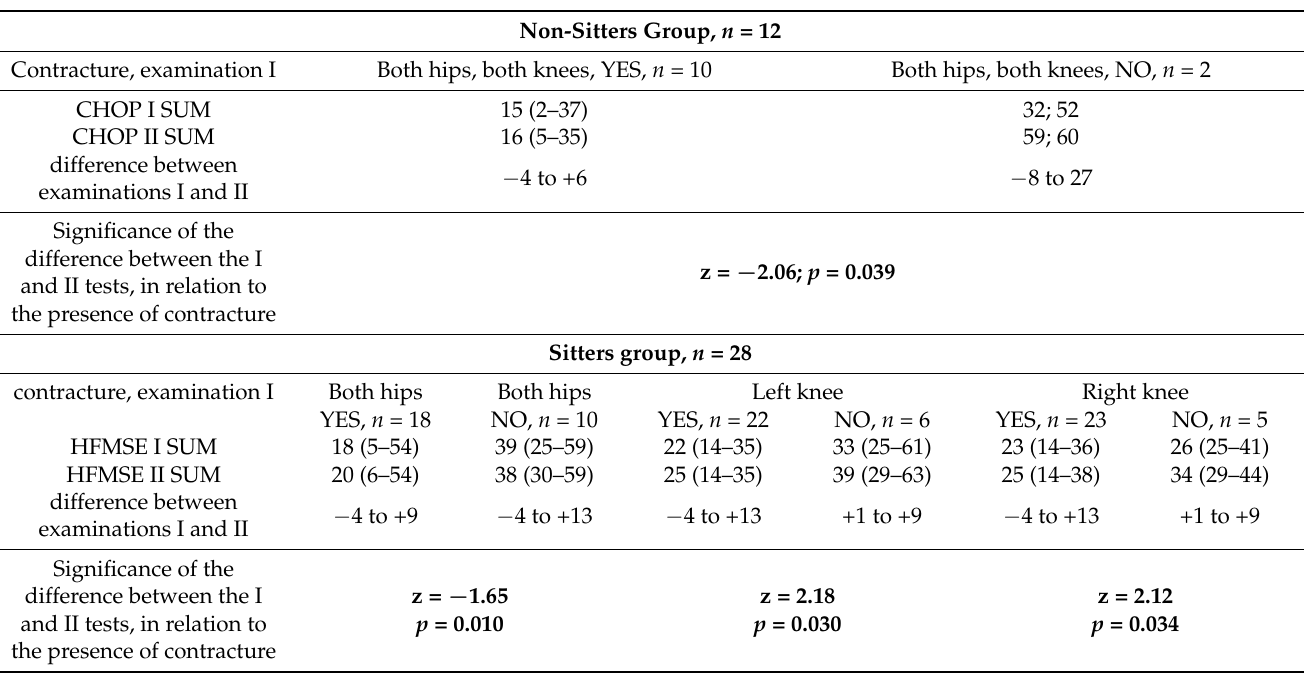
Table 4. Comparison of the difference in score in the respective scales, in relation to the presence of contracture in the initial joint position at the first examination. The Mann–Whitney U test was used to assess the significance of the difference between the subgroups, whereas the sign test was used to assess the difference in